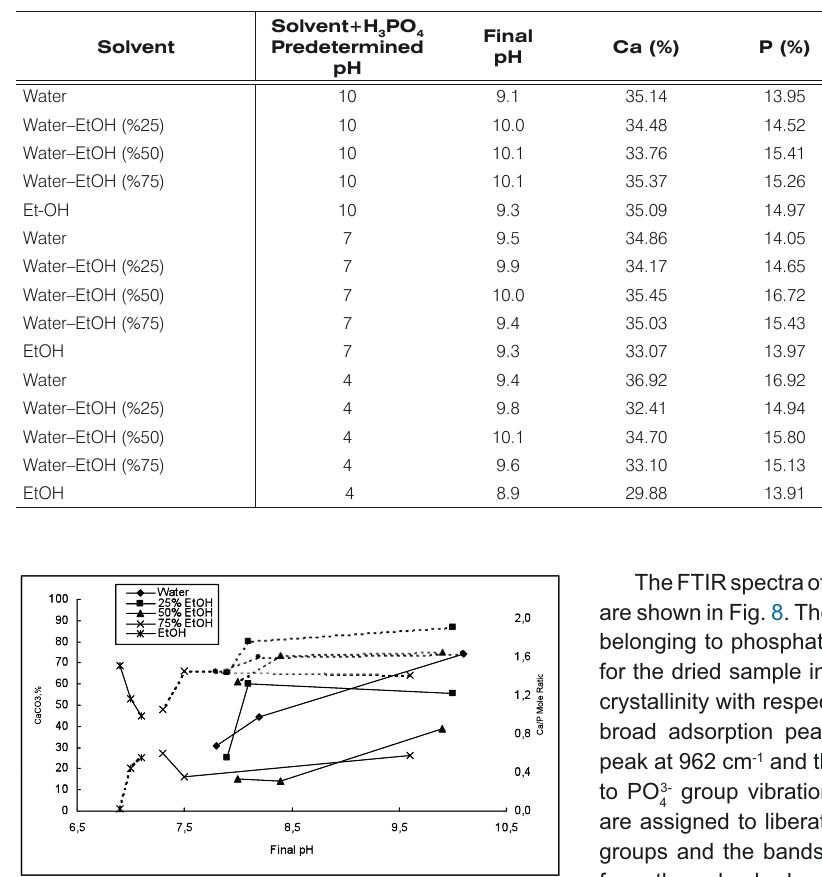
Table 2. Results of the experiments at 80 o C.